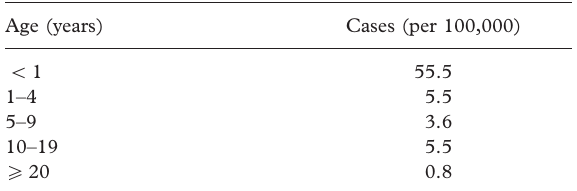
Table II. Average annual incidence rates of pertussis in the USA, 1997–2000